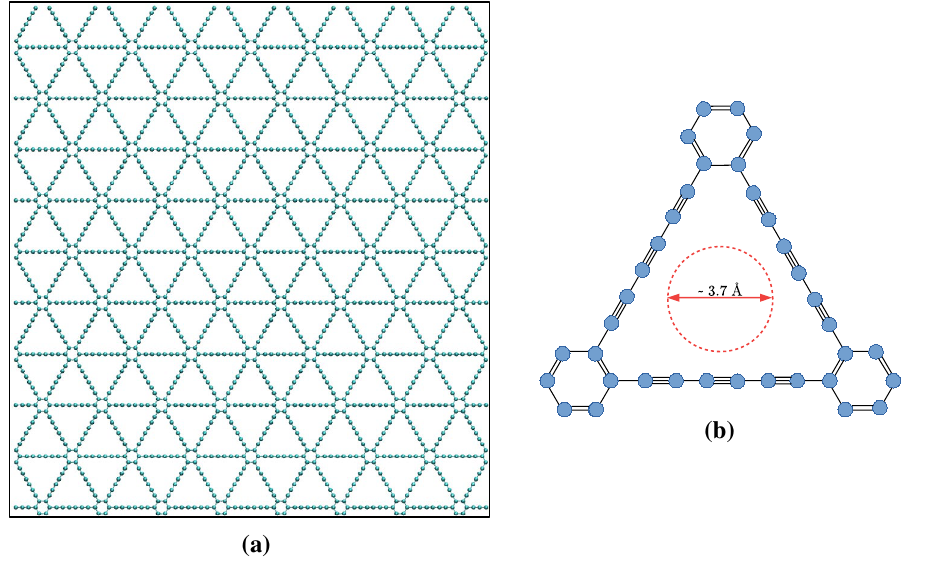
Figure 1. Structure of Graphyne-3. ( a ) The structure of the 2D sheet used as a membrane for gas separation. ( b ) The zoom-in structure, showing the atomic configuration. Blue dots are carbon atoms. The radius of the inscribed circle (pore radius) is about 3.7